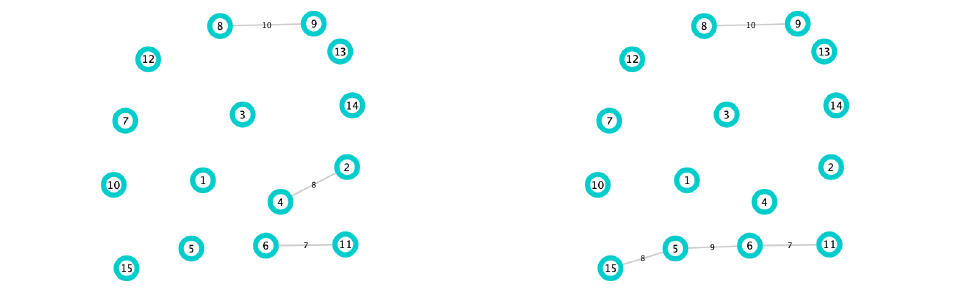
Figure 6. In the left, the first 3 protected places generated by the DIL-W 1 ranking. On the right, the first 3 protected places generated by Strength